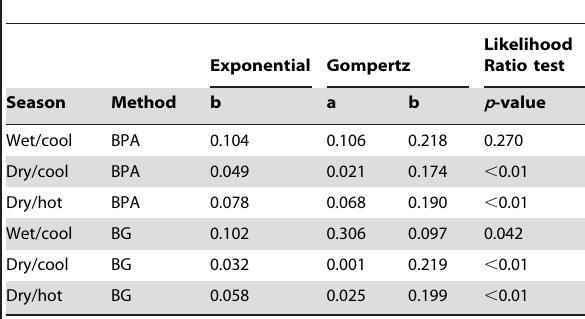
Table 4. Parameters for the exponential and Gompertz models used to describe the predicted age structures of Aedes aegypti collected from Tri Nguyen village.